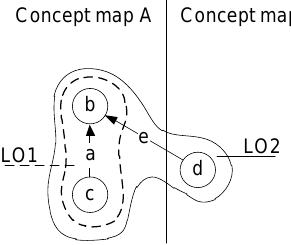
Fig. 12. An example of the use of merged concept map in IKAS Another way to extend IKAS functionality with merged